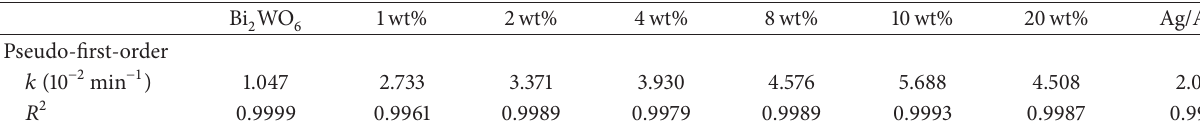
Table 2: Pseudo-first-order reaction rate constants for various processes.